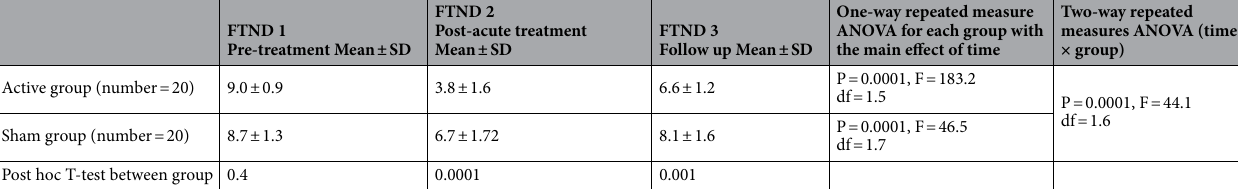
Table 3. Effects of HF-rTMS on nicotine dependence as measured by the Fagerstrom test for nicotine dependence pre-treatment (FTND1), post-acute treatment (FTND2), and follow-up (FTND3). FTND Fagerstrom test for nicotine dependence.